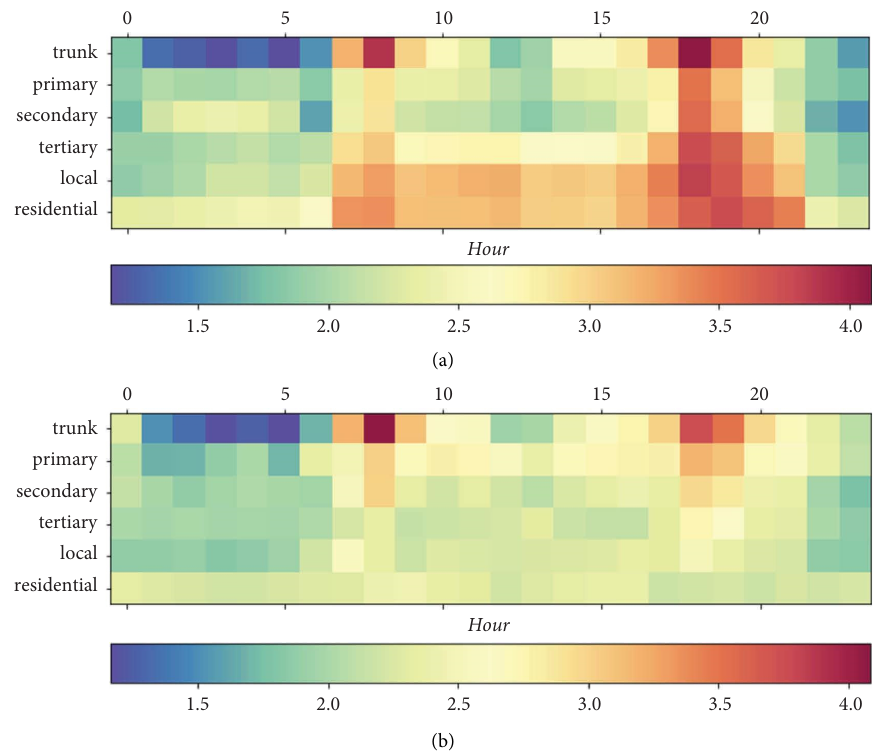
Figure 3: Hourly TPI distribution of diferent ranks of roads. (a) Hourly average TPI of the diferent ranks of roads. Te color is closer to red, and the road is more congested, on the contrary, the road is smooth. (b) Hourly standard deviation of the diferent ranks of roads. Te color is closer to red, and the TPI changes greater over time, on the contrary, the change is not obvious.